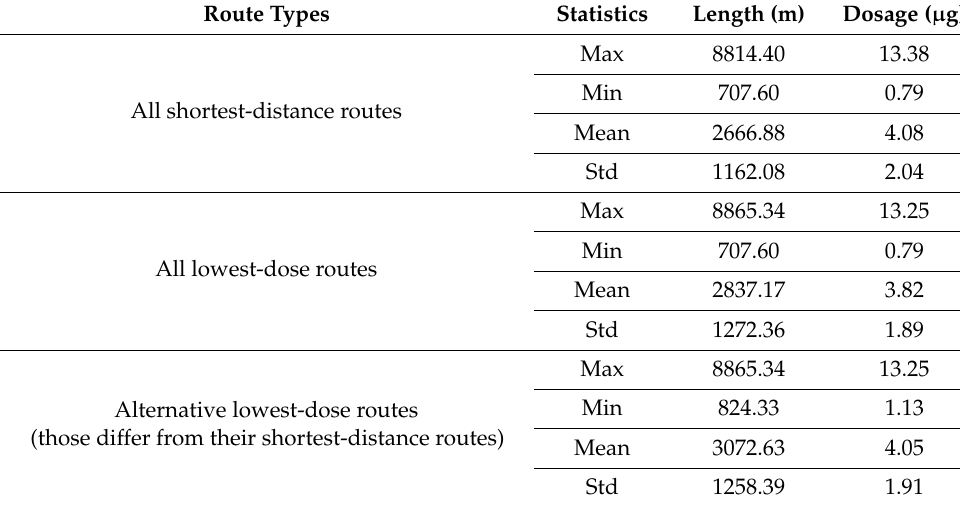
Table 2. Statistical results for all students cycling along different